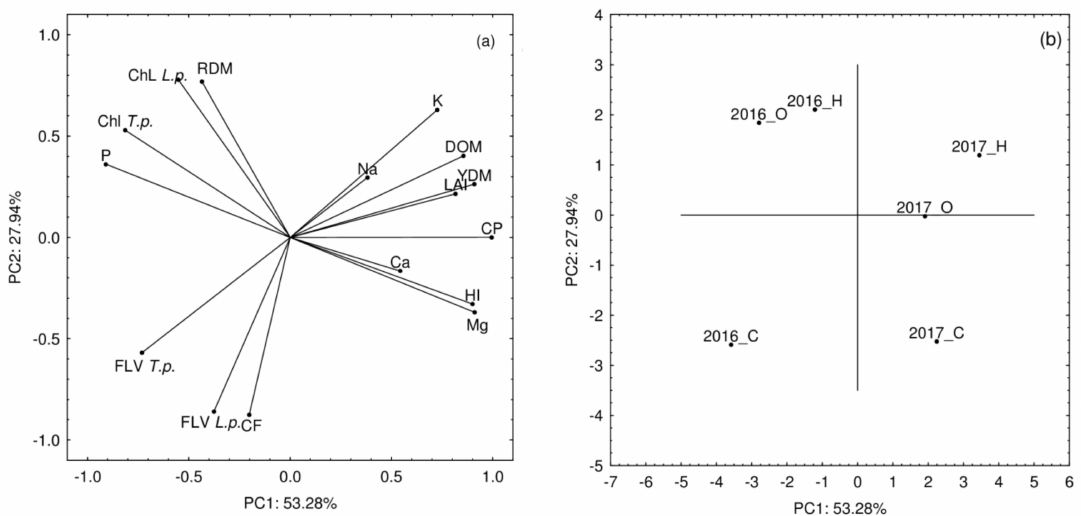
Figure 3. Results of principal component analysis (PCA) ( a ) presenting relationships between the traits: YDM—yield of dry matter, RDM—dry mass of roots, HI—harvest index, LAI—leaf area